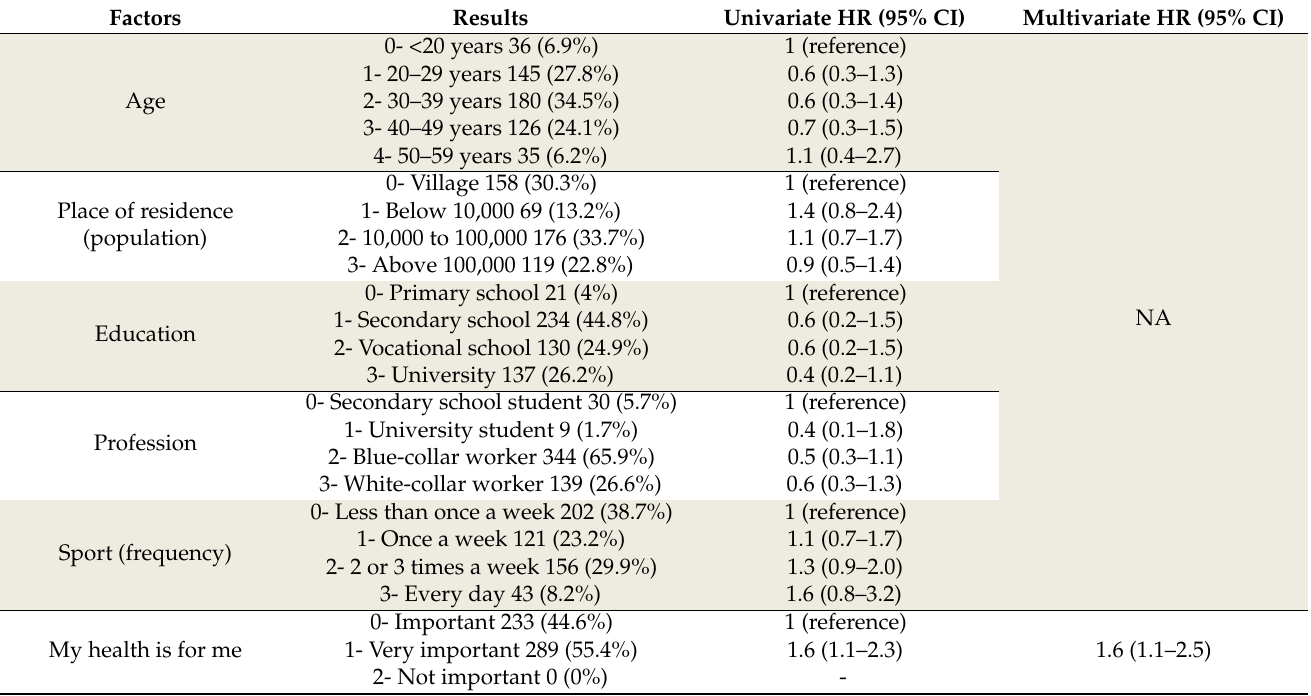
Table 1. Factors associated with practice of TSE among respondents (univariate and multivariate regression model); NA—not applicable in the final